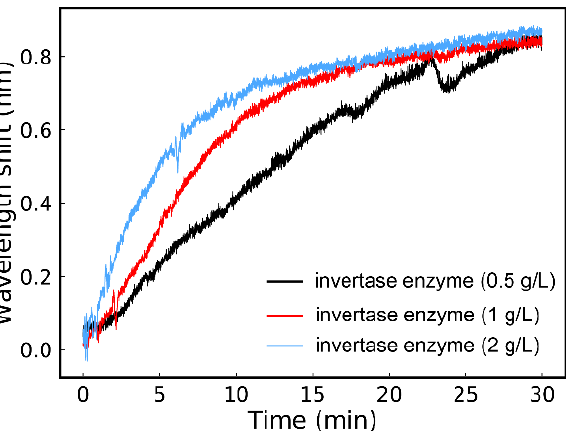
Figure 7. The real-time response of the wavelength shift for sucrose hydrolysis with different invertase enzymes.